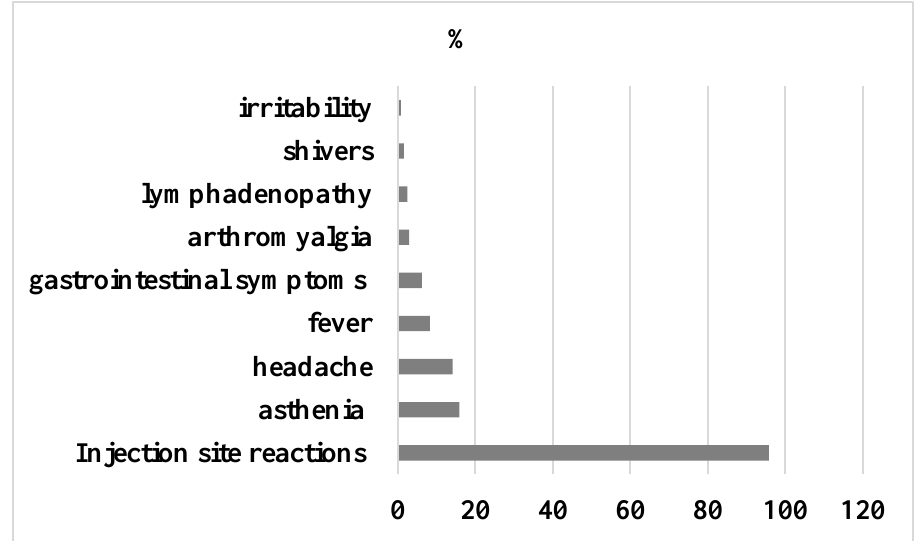
Figure 3. Adverse events 24 – 48 h after second dose.